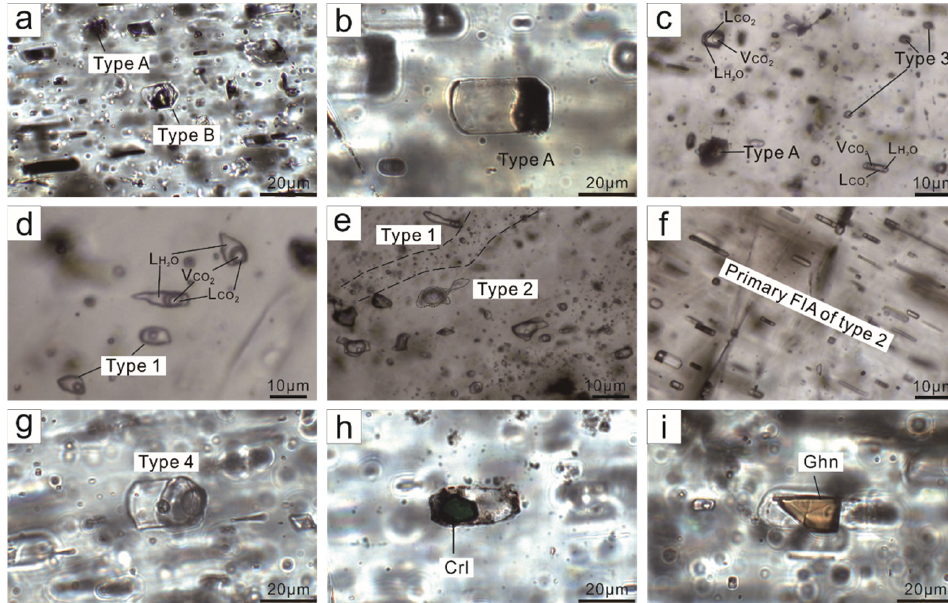
Figure 7. Transmitted-light photomicrographs of melt inclusions (MI), fluid inclusions (FI), and mineral inclusions in beryl IIa, IIb, and quartz crystals. ( a ) Type A and B inclusions in beryl IIa (20DK1-4); ( b ) Type B water-poor MI in beryl II (20DK1-4); ( c ) Three different inclusions in beryl IIa (type A, type 2, and type 3) (20DK1-4); ( d ) two different inclusions in quartz (type 1 and type 3); ( e ) two different inclusions in quartz (type 1 and type 2), part of type 2 FI appear to the necking-down phenomenon; ( f ) Primary type 2 fluid inclusions assemblage (FIA) are parallel to c-axis of beryl IIb(20DKLS1-1); ( g ) Silicate daughter mineral-bearing inclusion (type 4 FI) hosted by beryl IIa (20DK1-4); ( h ) Solid cryolite (Crl) inclusion in beryl IIa (20DK1-4); ( i ) Solid gahnite (Ghn) inclusion in beryl IIa (20DK1-3).